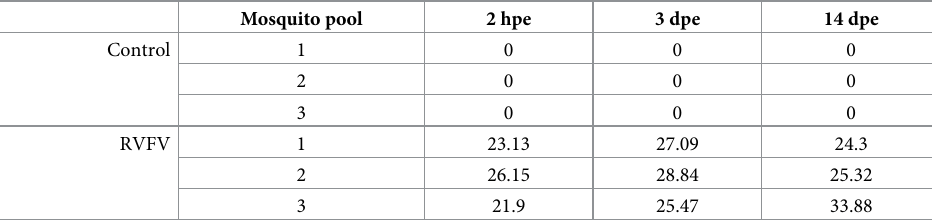
Table 1. Viral load (Ct values) in mosquito pools tested by RT-qPCR specific to RVFV. Pools were composed of four mosquito